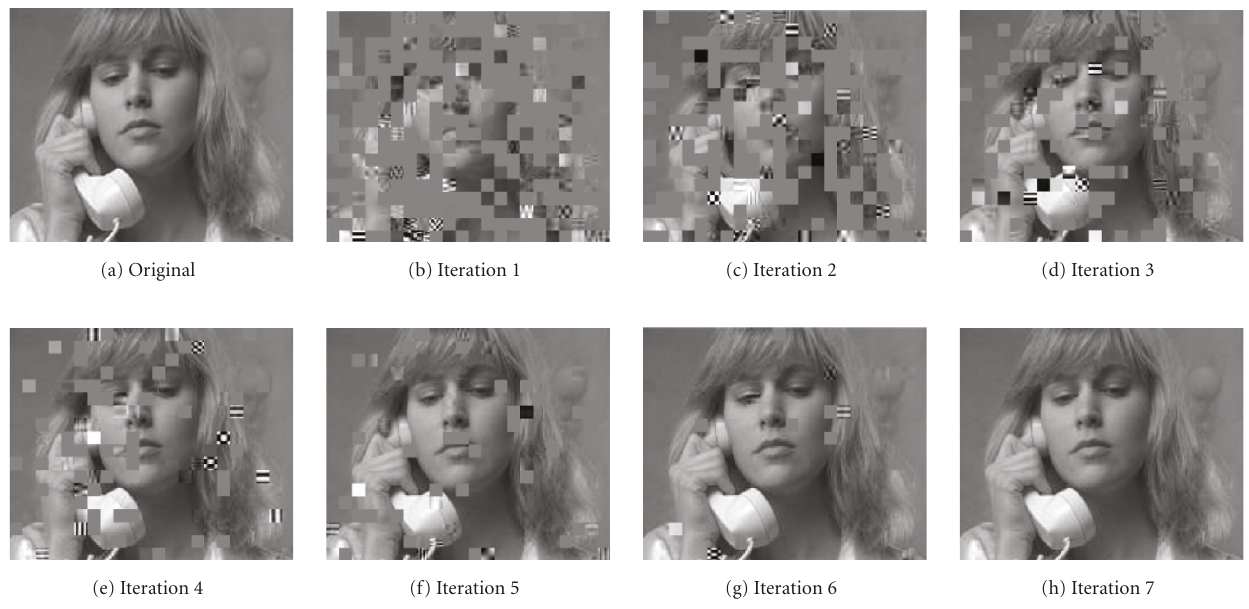
Figure 14: Original and decoded “Suzie” images over AWGN channel using proposed asymmetric turbo code without interleaver with an /N E b 0 of 2dB.